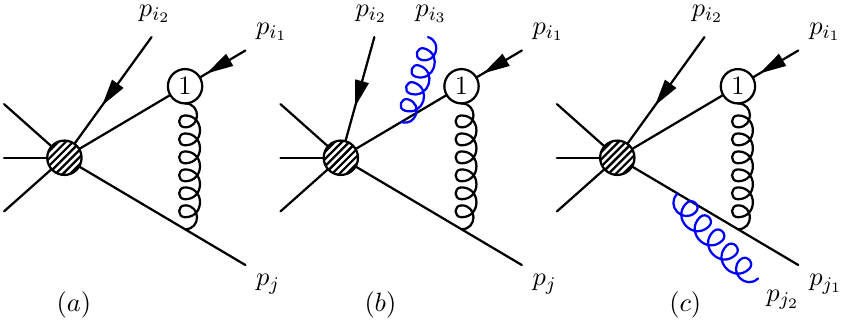
Figure 5 . Sample diagrams contributing to mixing of time-ordered product into power-suppressed local operators. The circle denotes the O ( λ ) SCET Lagrangian insertion. Diagram (a) contributes to mixing into N -jet operator with B2-type currents; the diagram (b) can induce mixing into C2-type currents and the diagram (c) can generate mixing into an N -jet operator containing two different B1-type